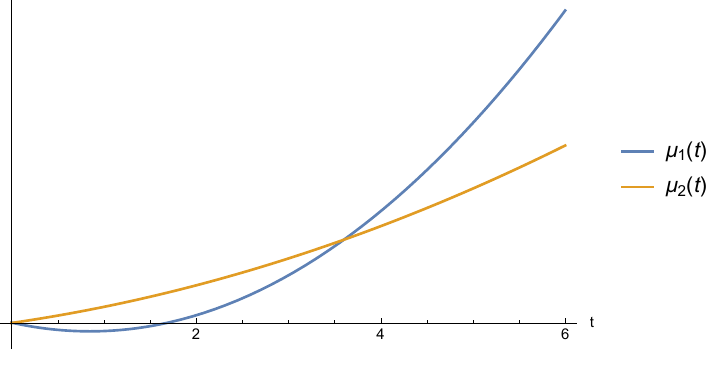
Fig. 15 The solutions of the initial value problem 40–41 for α = 0 .